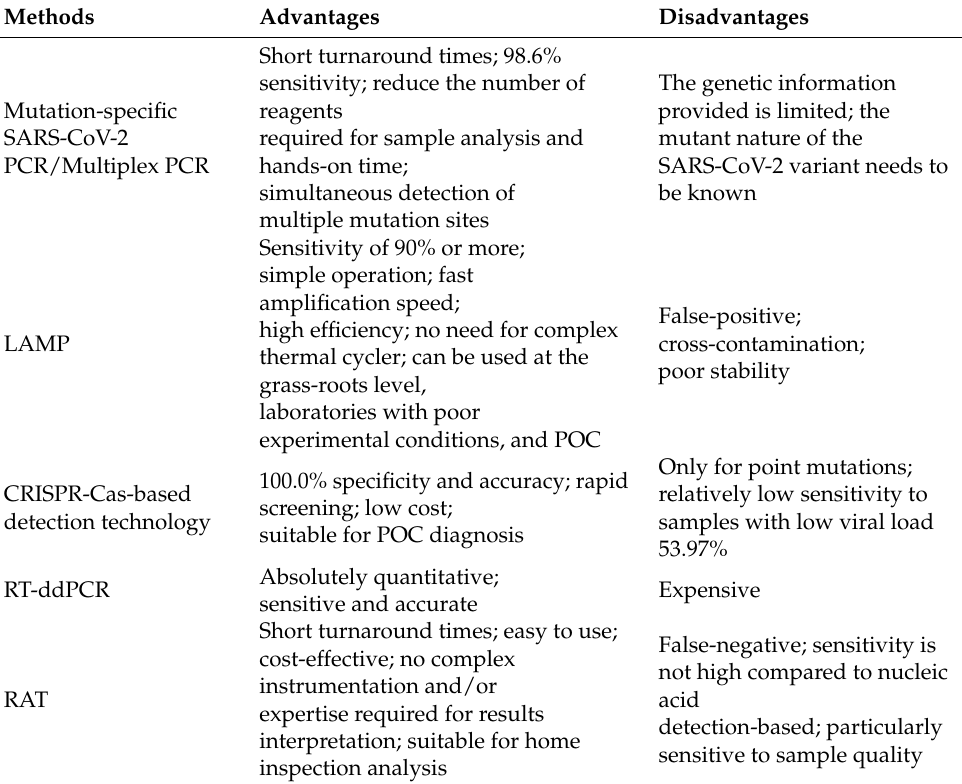
Table 3. Comparison of Different SARS-CoV-2 VOCs Detection